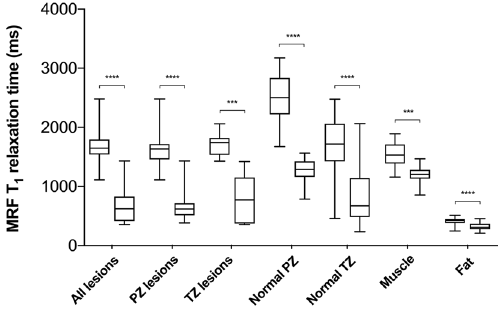
Figure 5. Box-and-whisker plots comparing MRF T 1 relaxation times obtained before and after gadolinium- based contrast agent administration in prostate lesions, pooled normal PZ and TZ, internal obturator muscle and subcutaneous abdominal fat. MRF magnetic resonance fingerprinting, PZ peripheral zone, TZ transition zone. ****p < 0.0001, ***p =